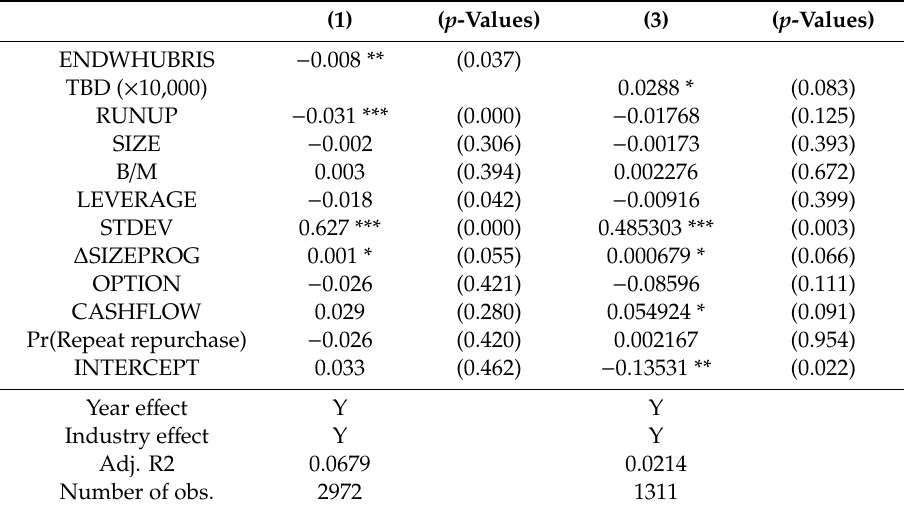
Table 7. Regressions of repeat repurchasers’ abnormal